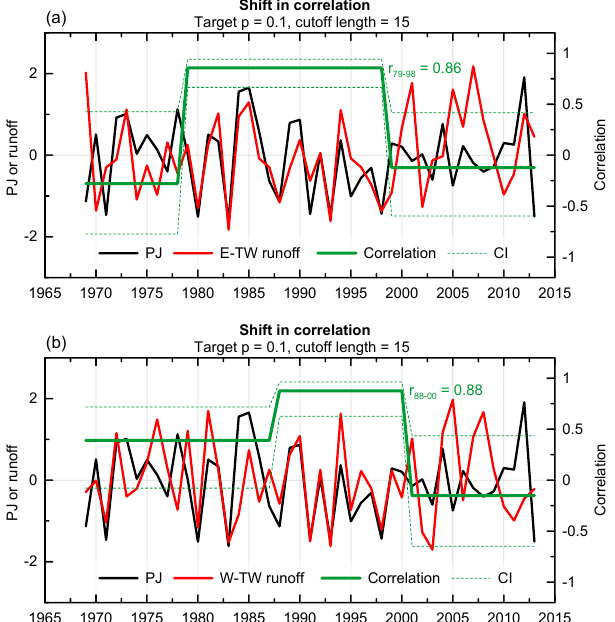
Figure 5. Shifts in the correlation between ( a eastern; b western) Taiwan runoff and the PJ index.